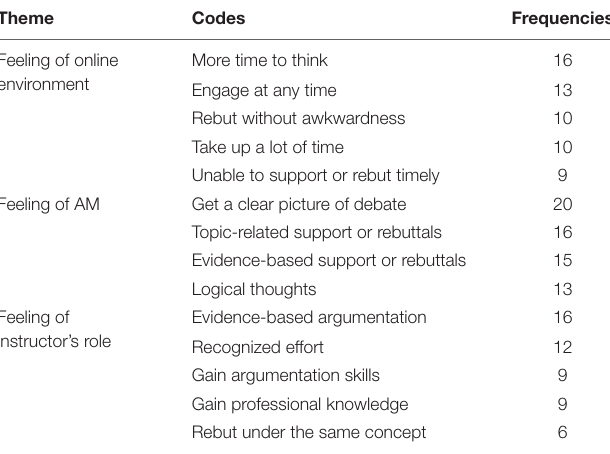
TABLE 6 | Debaters’ effective single sequences in the first and second team in five debates.